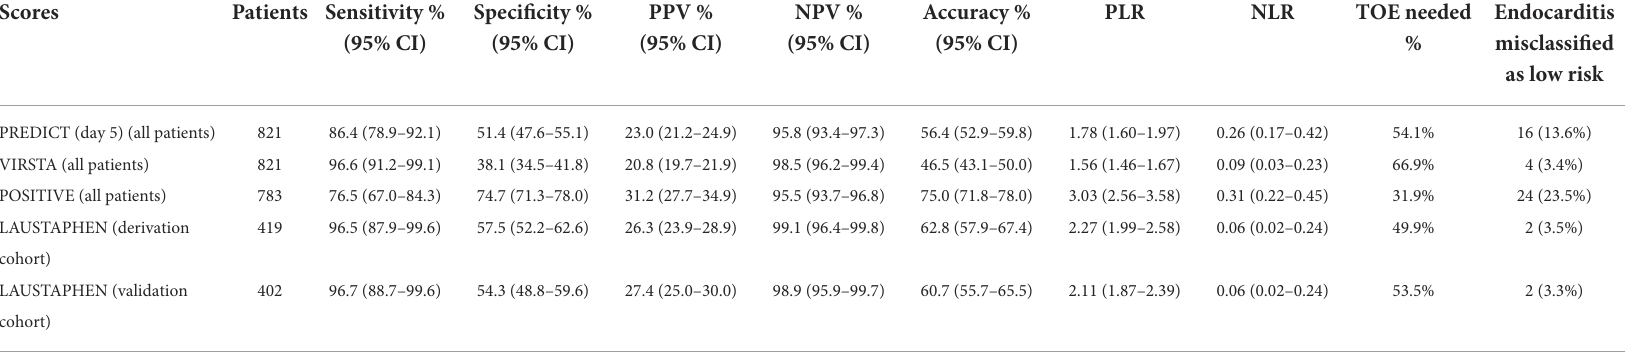
TABLE 3 Diagnostic accuracies of the fifth day PREDICT, VIRSTA, POSITIVE, and LAUSTAPHEN in predicting definite IE (according to the 2015 ESC-modified Duke Criteria).